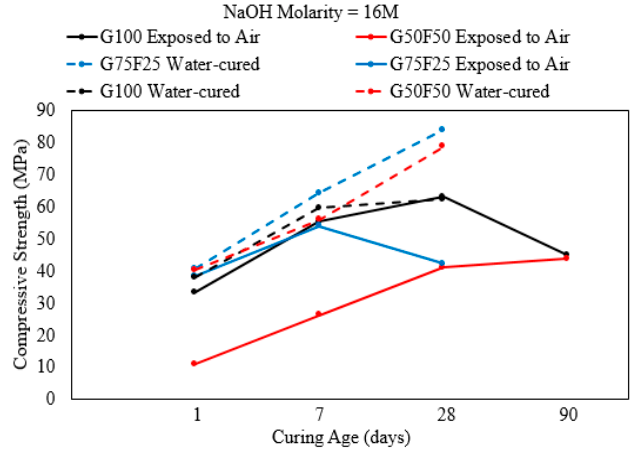
Figure 8. Strength development of mortar with an AASF binder cured in air or in a closed curing system with NaOH activator molarity = 16 M [2].